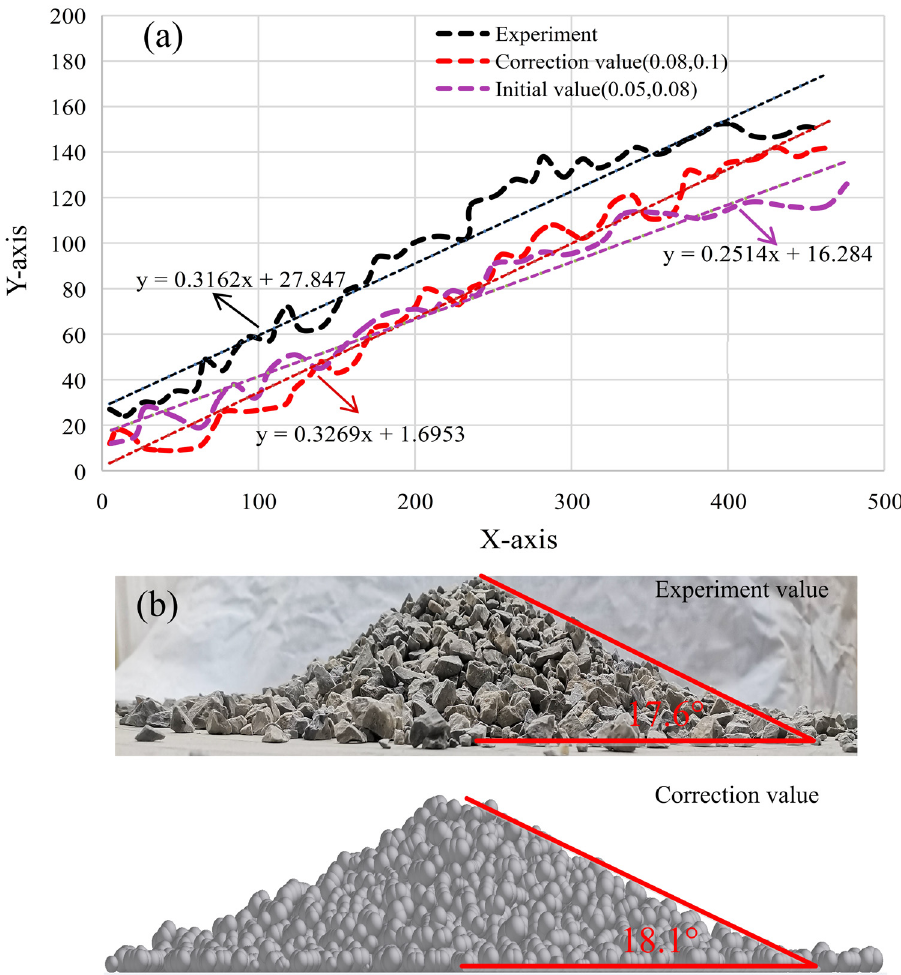
Figure 8: Fitting results of the angle of repose for gravel ( a ) and simulation and experimental diagram of repose angle ( b )